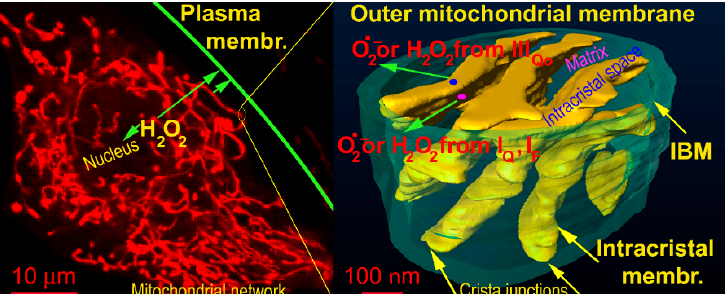
Figure 1. Representation of distances for hypothetic H 2 O 2 diffusion to plasma membrane — demonstrated on a confocal image of the mitochondrial network (left) and FIB/SEM 3D image of cristae within a segment of the mitochondrial network (oriented vertically). The arrows show diffusion distances from the most proximal and most distant tubule of the mitochondrial network to the plasma membrane (left) and diffusion from the matrix (translucent space inside the IBM cylinder) or from then intracristal space (yellow topology, which also comprises ATP synthase oligomers and respiratory chain supercomplexes).